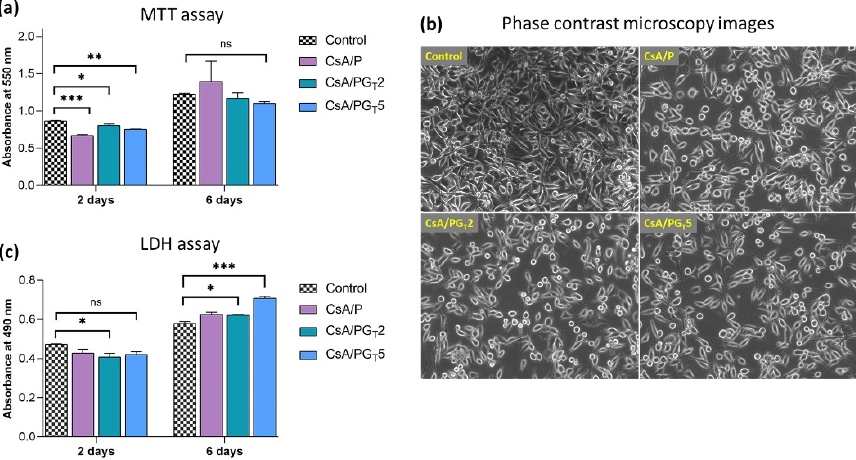
Figure 8. In vitro biological analysis of nanofibrous membranes. ( a ) MTT assay—viability and proliferation of NCTC fibroblast cells grown onto the surface of nanofibrous membranes, after 2 and 6 days (ns p > 0.5, * p < 0.05, ** p < 0.005, *** p < 0.0005). ( b ) Phase contrast microscopy images of NCTC cells. ( c ) LDH assay—quantification of dead NCTC fibroblasts after 2 and 6 days (ns p < 0.5, * p < 0.05, *** p <